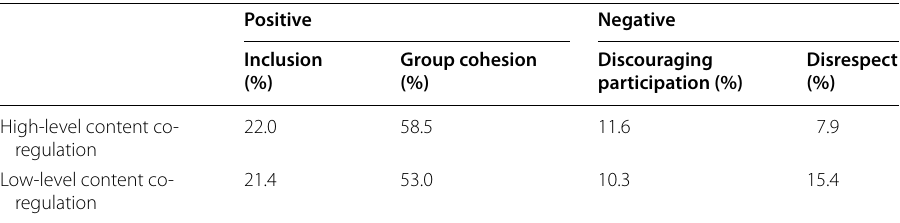
Table 3 Distribution of socioemotional indicators (categorical variables) in both types of co-regulation episodes Positive Negative Inclusion Group cohesion (%) (%)